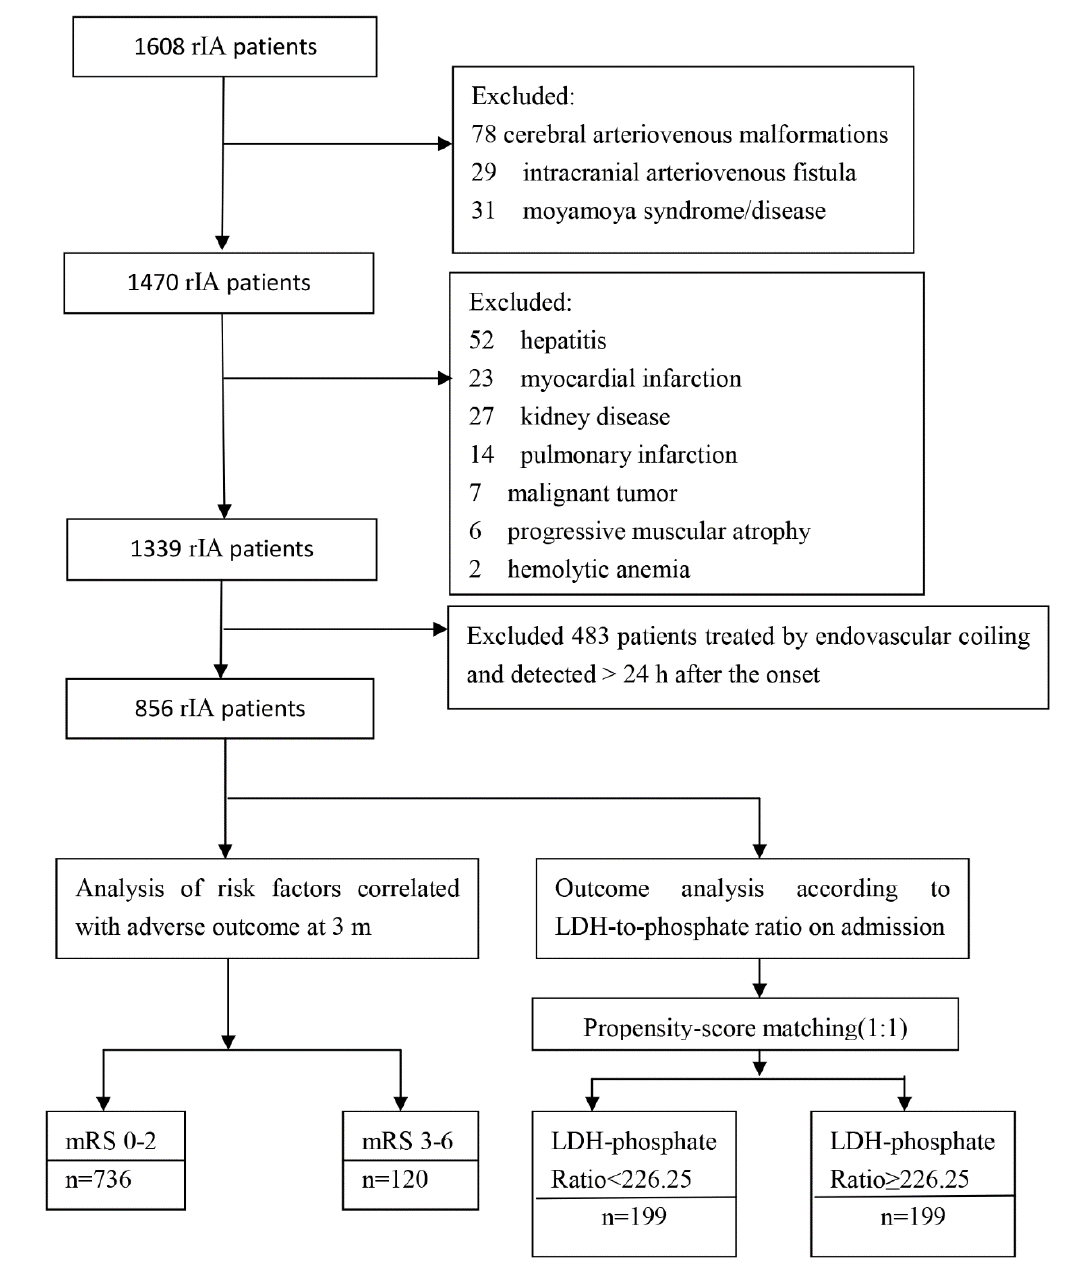
Figure 1. Flowchart of the study.